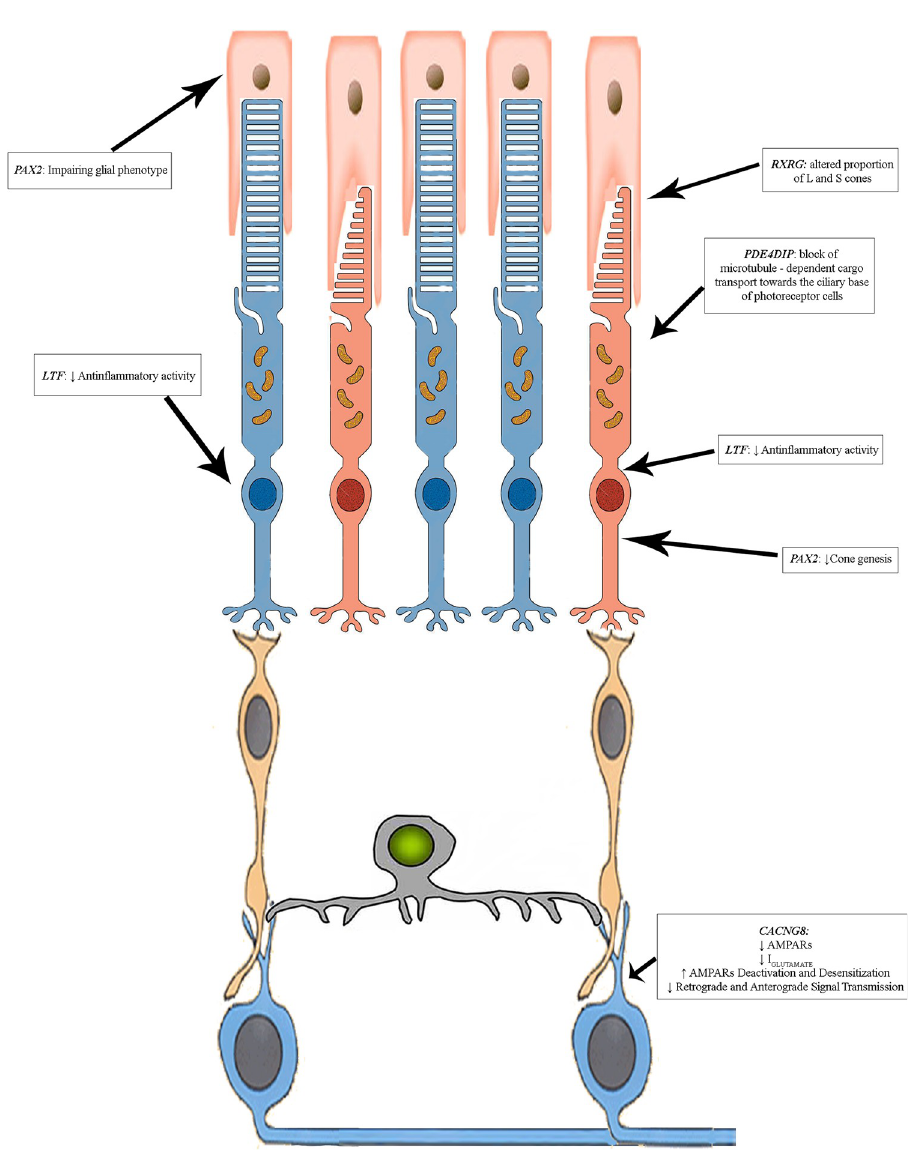
Fig 9. Proposed regulatory pattern related to CORD pathogenic mechanisms. Our hypothesis is based on primary cone compromised activity, originated from GUCY2D defects, might worsened by altered retrograde signaling from the inner retinal cells due to variants carried by candidate modifier genes. CACNG8 c. � 6819A > T could decrease the expression of TARP γ -8 physiologically interacting with DACs and RGCs AMPARs, reducing the retrograde and anterograde signal transmission determining, respectively, an impairment of optic nerve activity and co death. Additionally, the presence of the RXRG c.875+6A > G and PAX2 c.-375C > A may have already compromised cones and their differentiation, probably involving astrocytes and other neural supporting cells, especially in RPE. This scenario could also promote rods death, due to the lack of the fundamental anti-inflammatory activity of lactotransferrin (failed because of LTF c.85G > A and c.140A > G and, probably, of CCDC175 c.-79C > G and c.76 C > T), and due to the reduced expression of PDE4DIP (caused by the two 3’ UTR variants c. � 39G > A and c. � 105 G > A), which could prevent the proper transport of phototransduction proteins between the inner and the outer photoreceptor segments. More details in the